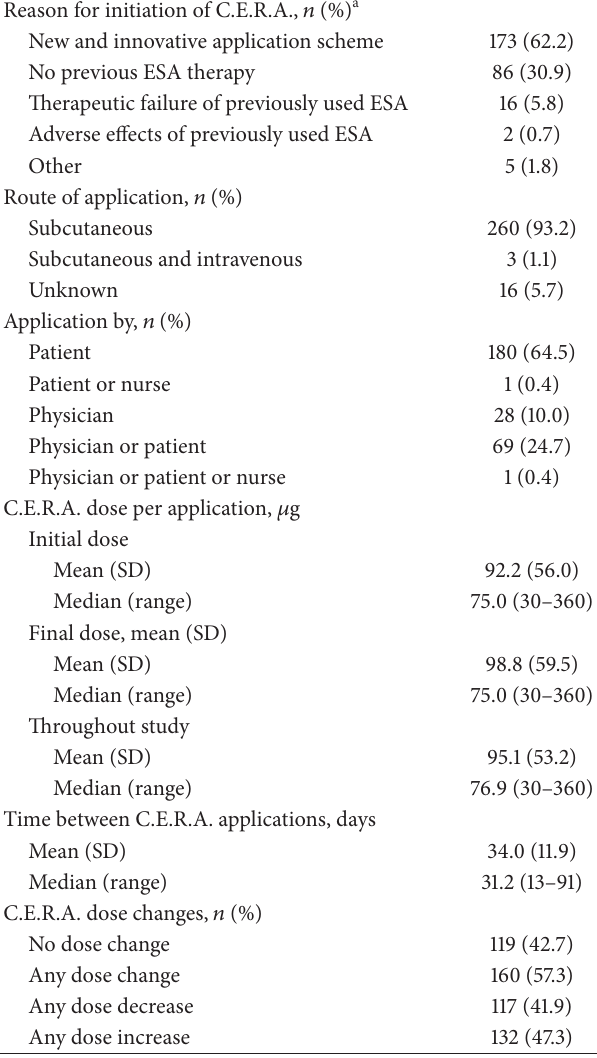
Table 2: C.E.R.A. administration (safety population, 𝑛 = 279 ). Reason for initiation of C.E.R.A., 𝑛 (%)